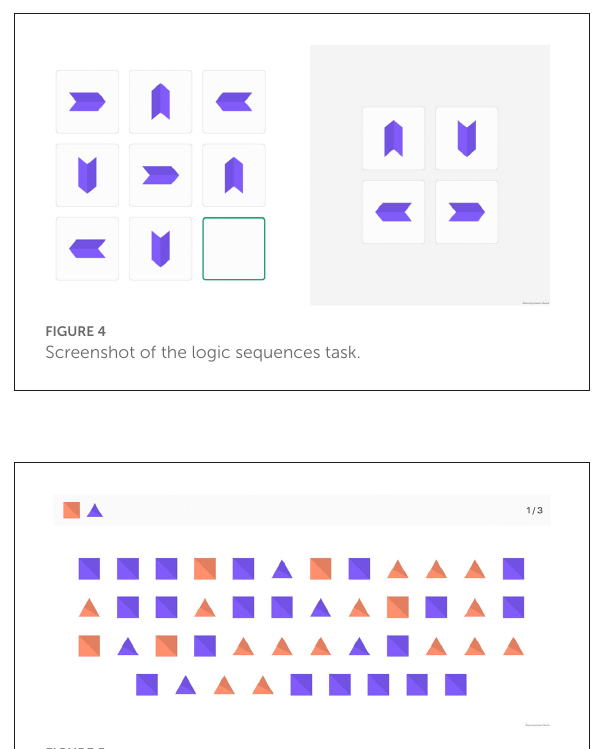
FIGURE5 Screenshot of the cancelation task in the two targets mode.